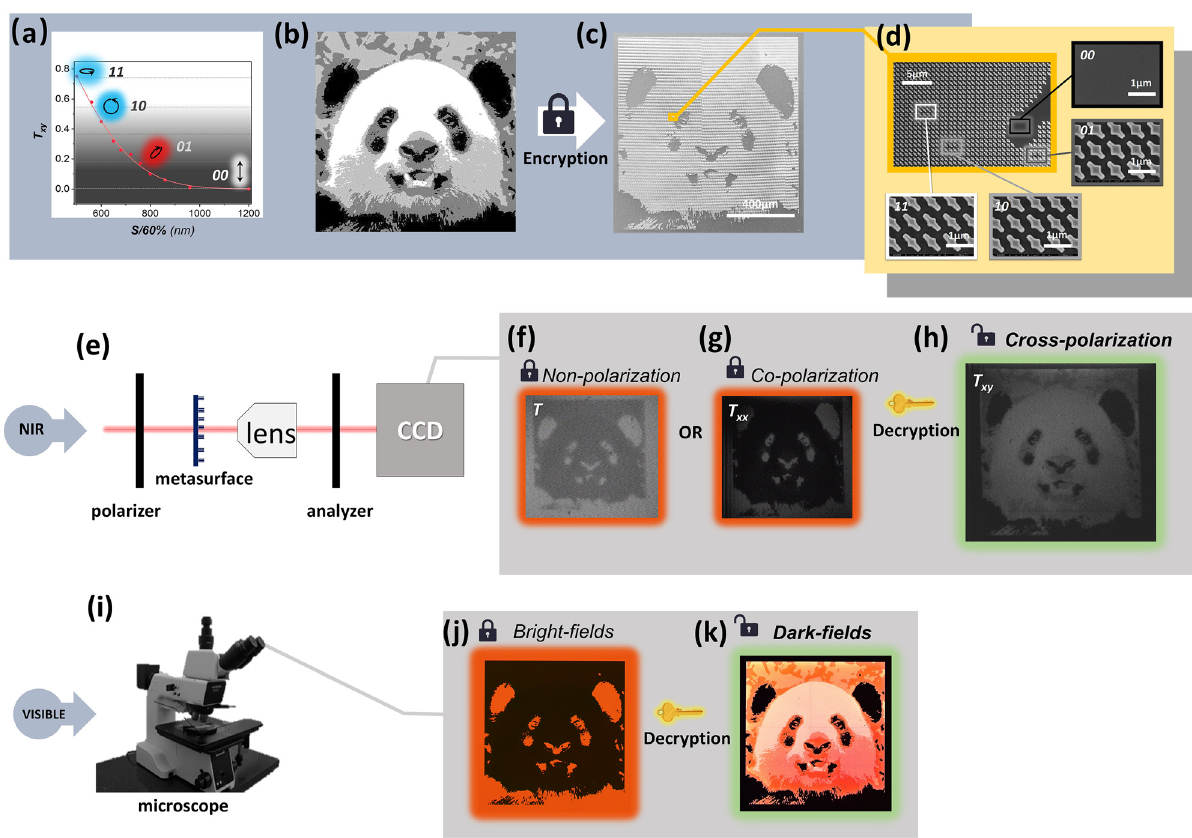
Figure 4: Single-channel image storage for high-resolution grayscale image encryption. (a) Simulated cross-polarization transmissivities ( T xy ) of CNs with different s , and the local output polarization of four types of CNs in (d) are alsomarked.(b)Original2-bitgrayscaleimageofapanda.(c)SEMimageofencryptedmetasurface,anditiscomposedoffourkindsofCNs.(d) Enlarged SEM images of the encrypted metasurface in (c), and there are four kinds of CNs in this region. The numbers on the images demonstrate the 00, 01, 10 and 11 grayscalevaluesof the corresponding pixels. (e) Experimental setup to characterize the encrypted imagein the band from 1.2 to 1.9 µm. (f) – (h) Infrared microscopic images of the encrypted metasurface observed by unpolarized transmission light, copolarizedtransmissionlightandcross-polarizedtransmissionlight.(i)Pictureofmicroscopeoperatinginvisibleband.(j)and(k)Dark- fi eld and bright- fi eld microscopic images of the encrypted metasurface observed in visible